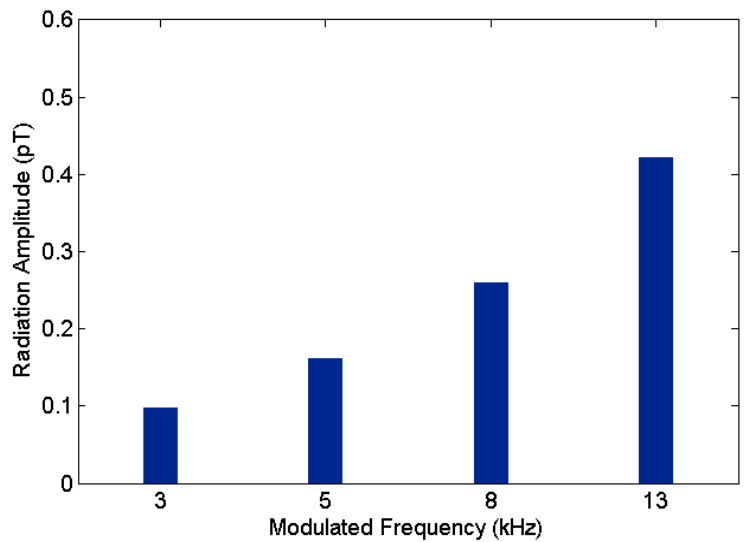
Figure 4. Numerical simulation of radiation amplitude of ELF/VLF waves at several modulated frequencies (3 kHz, 5 kHz, 8 kHz, 13 kHz) generated by BW modulation with the same parameters of ionosphere (4 April 2010, 0800 UT, HAARP) and HF waves (3.2 MHz, 570 MW, X-wave) as in Figure 3.